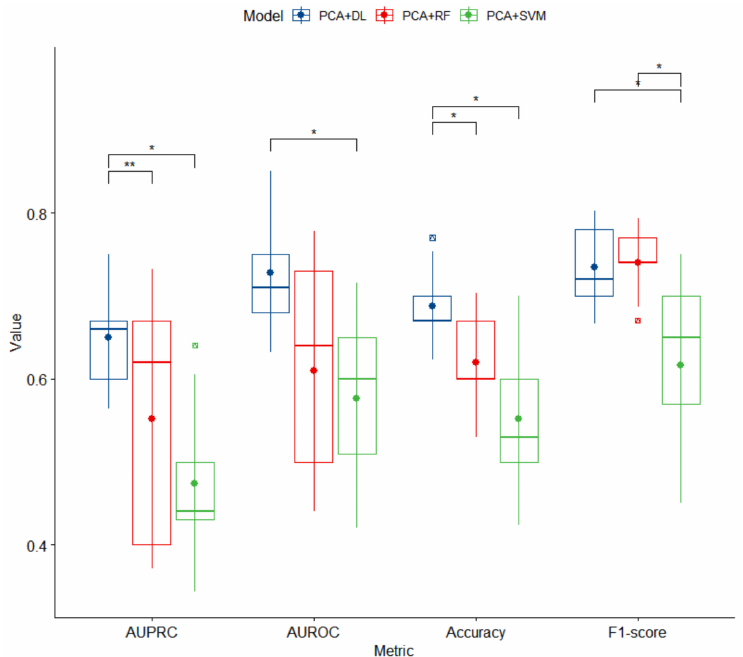
Figure 1. Box plots of performance of three proposed models for high BP prediction. PCA, principal component analysis; DL, deep learning; RF, random forest; SVM, support vector machine; AUPRC, area under the precision-recall curve; AUROC, area under the receiver operator characteristics curve. An asterisk (*) denotes a significant difference with p -value < 0.05. A double asterisk (**) denotes a significant difference with p -value <